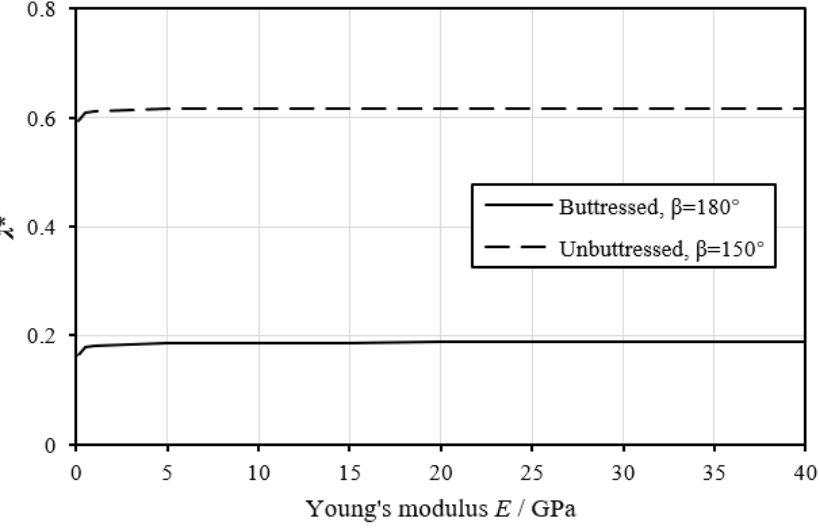
Figure 13. Influences of Young’s modulus of masonry blocks on the seismic capacity.